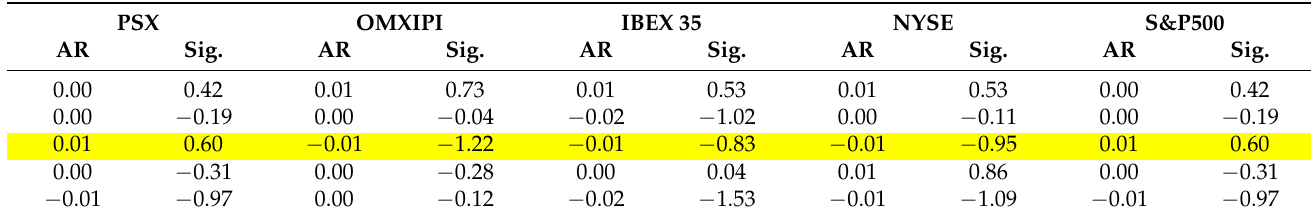
Table A5. Abnormal returns for the ( − 2, +2) event window (News of Panama leaks).